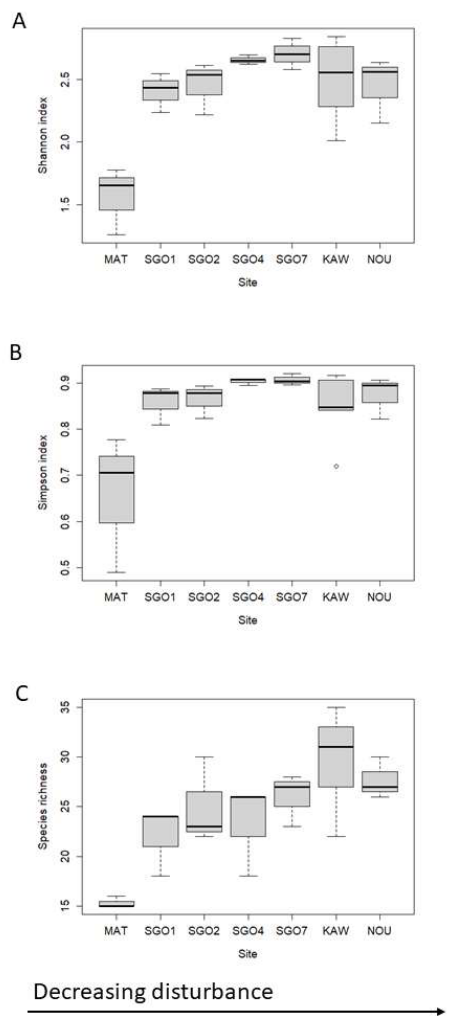
Figure 2. Boxplots of ( A ) species richness, ( B ) Shannon and ( C ) Simpson indexes at SGO sites and sites in Feer & Boissier (2015), i.e., Kaw (KAW), Matoury (MAT) and Nouragues (NOU). Table 3. Spearman Rank Correlation test of species richness, Shannon and Simpson indexes with distance to the city (Distance) and forest cover loss (Forest) for the four SGO sites and the other sites in the Feer & Boisier [8] study, i.e., Nouragues, Kaw and Matoury. Distance to the City